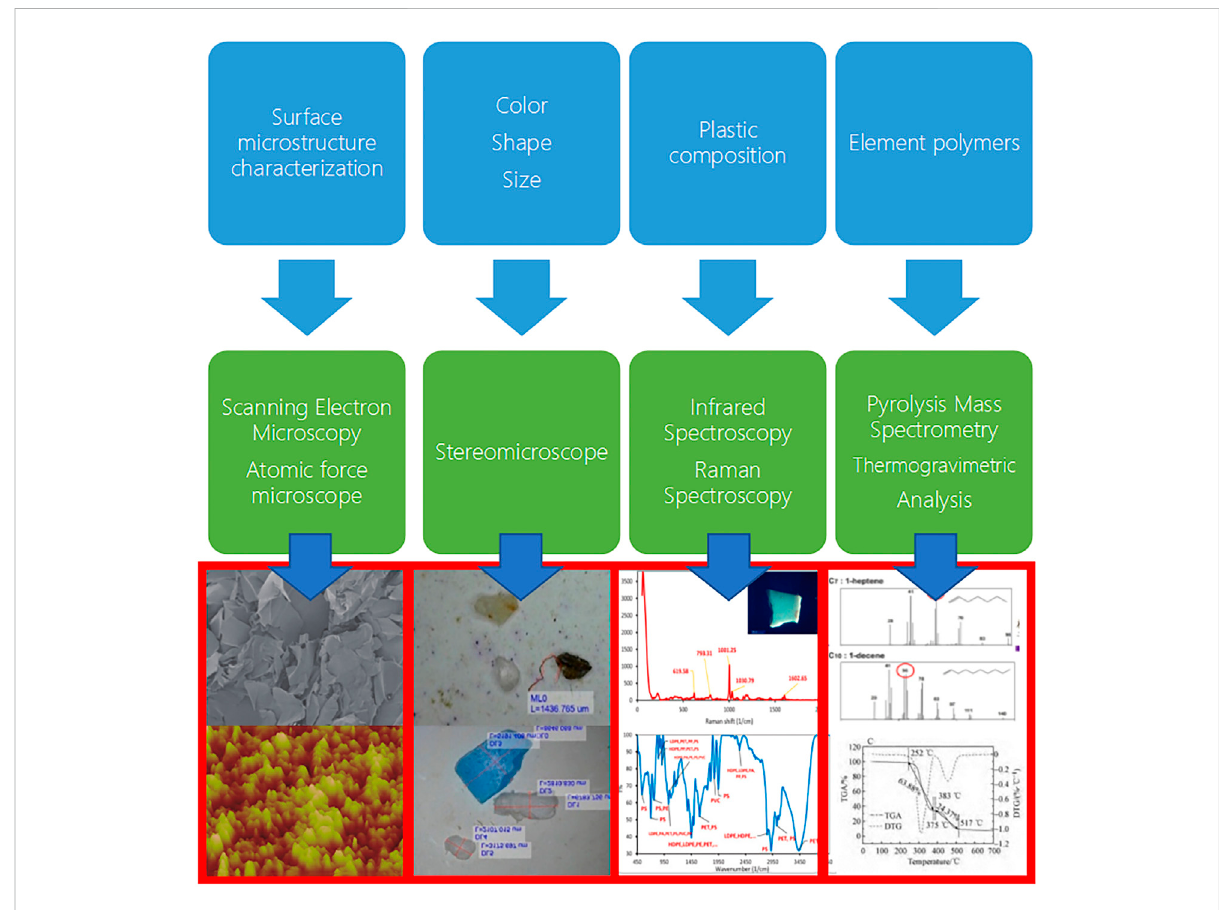
FIGURE 2 Illustration of microplastic fugacity characteristics and identi fi cation